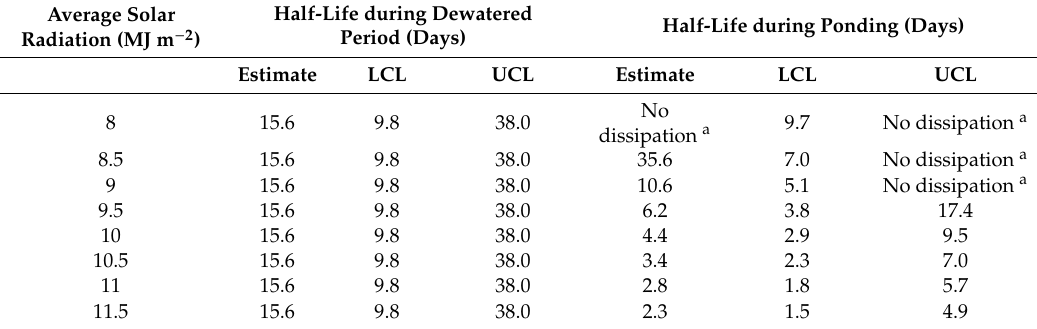
Table 4. Days to dissipate imazapyr in the water column and days to “dissipation” in the dewatered period for di ff erent levels of average solar radiation during the ponding period. LCL = Lower 95% confidence limit; UCL = Upper 95% confidence